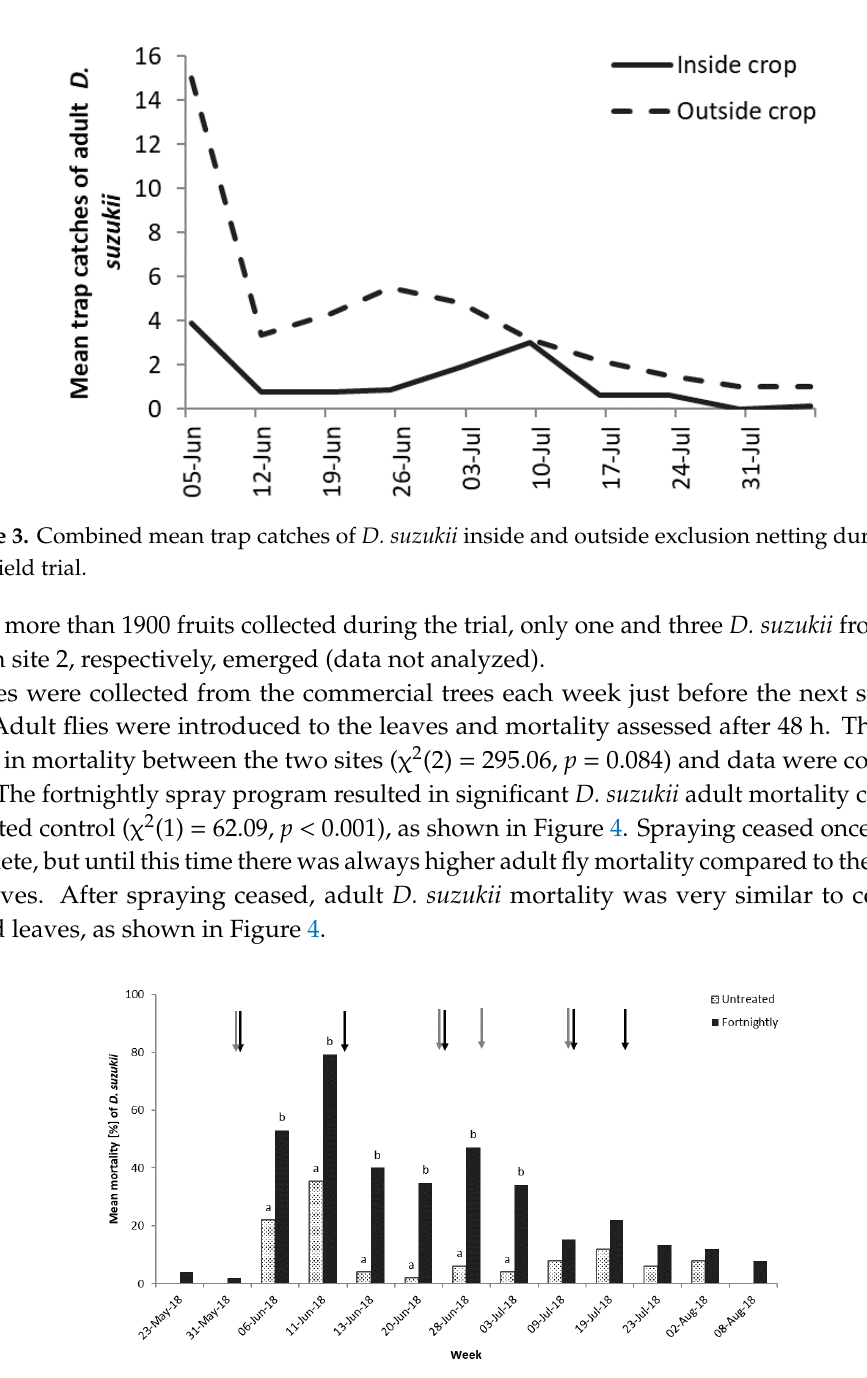
Figure 4. Mean adult D. suzukii mortality (%) at 48 h after exposure to cherry leaves sprayed with a fortnightly program compared to an unsprayed control leaves ( n = 5). Data was analyzed using binomial GLM with logit link function. Different letters denote significant differences at each assessment date (Tukey’s HSD, α = 0.05). Arrows indicate spray applications at farm site 1 (black) and farm site 2 (grey).